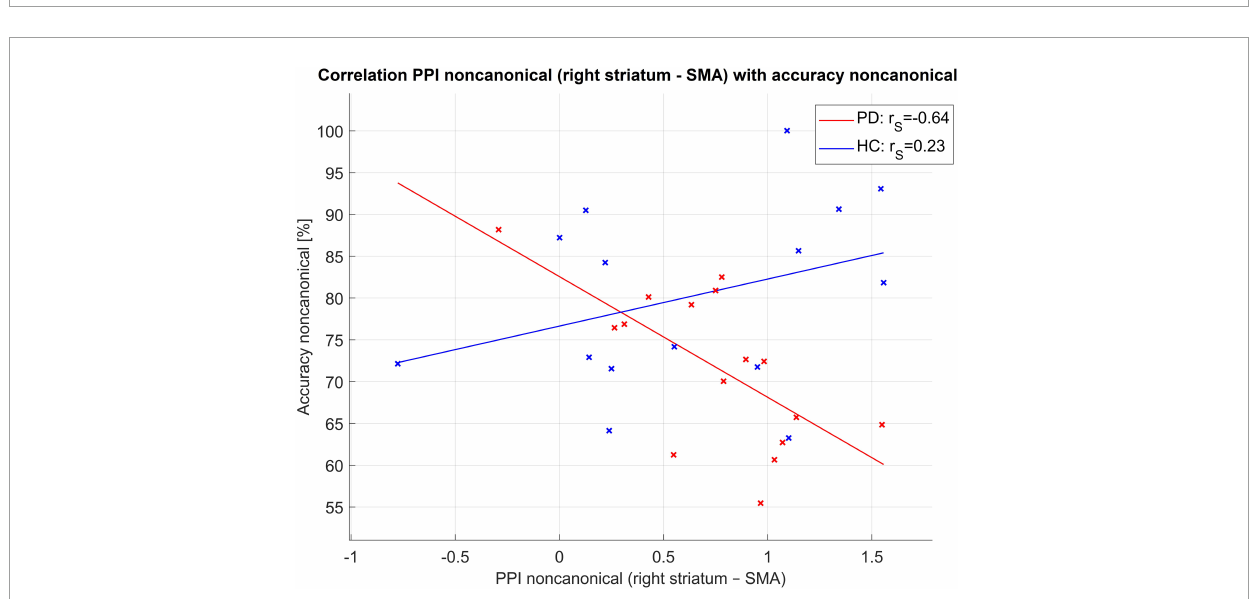
FIGURE3 Correlation of PPI connectivity seed striatum right to SMA and accuracy of non-canonical sentences. Here r S for Spearman correlation